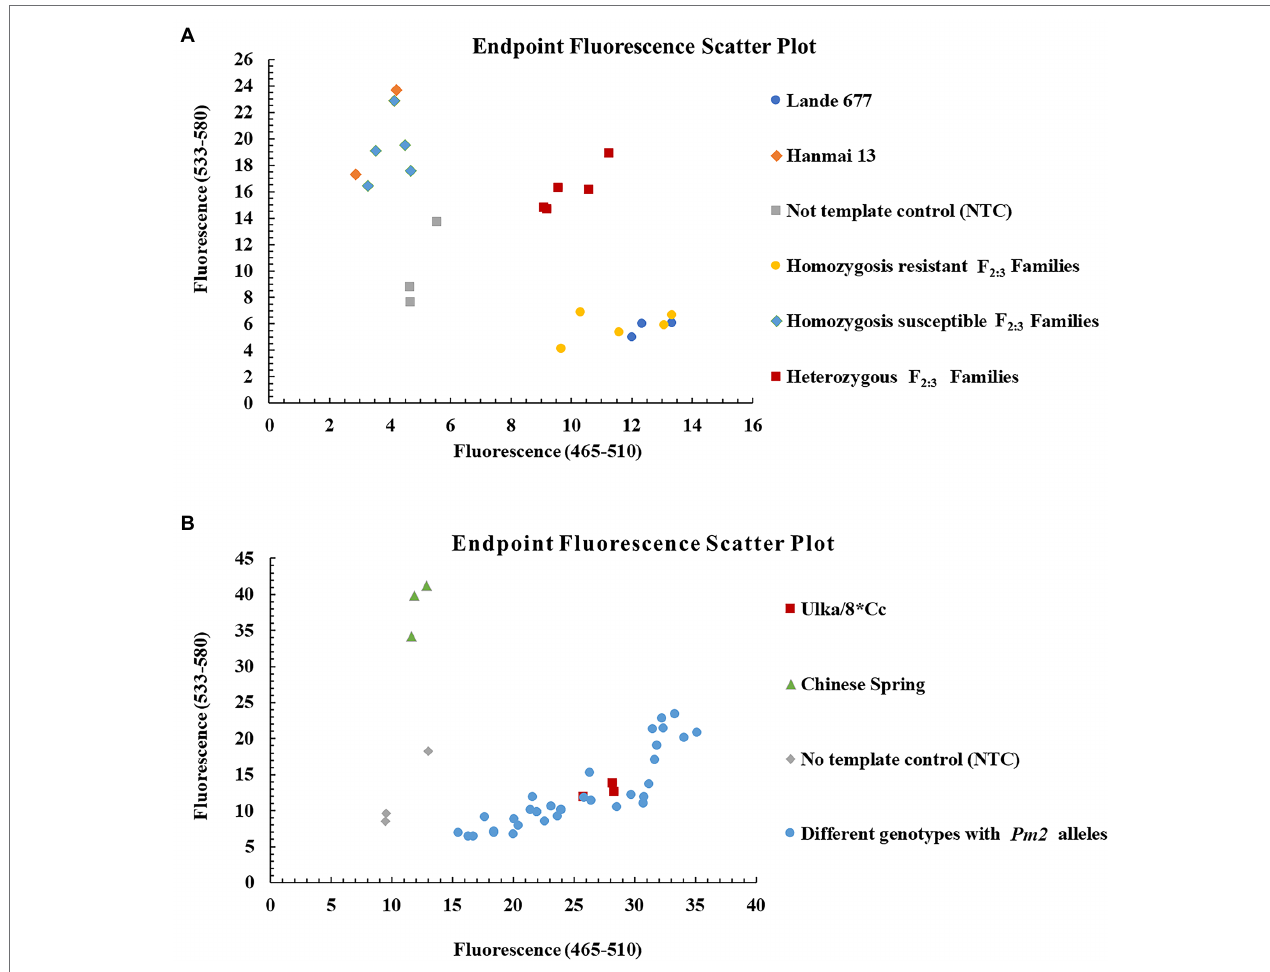
FIGURE 6 | Genotyping results of the Pm2 diagnostic kompetitive allele-specific PCR (KASP) marker YTU-KASP-Pm2 for Lande 677 ( Pm2 donor), Hanmai 13 and randomly selected F 2:3 families of Lande 677 × Hanmai 13 (A) and different genotypes with Pm2 alleles (B)